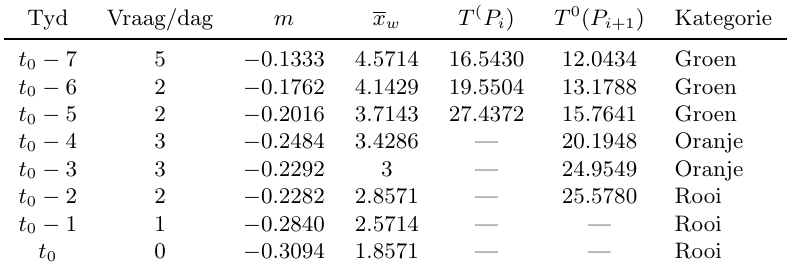
Tabel 5: Resultate vir Algoritme 2 ′